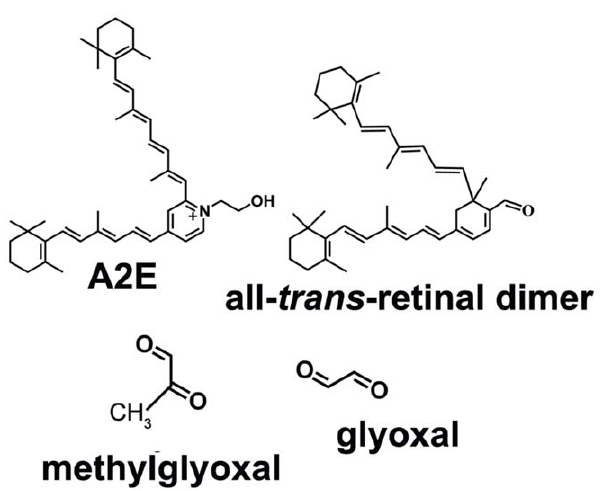
Figure 1. Structures of the bisretinoids A2E and all- trans -retinal dimer; and the oxo-aldehydes, methylglyoxal and glyoxal.